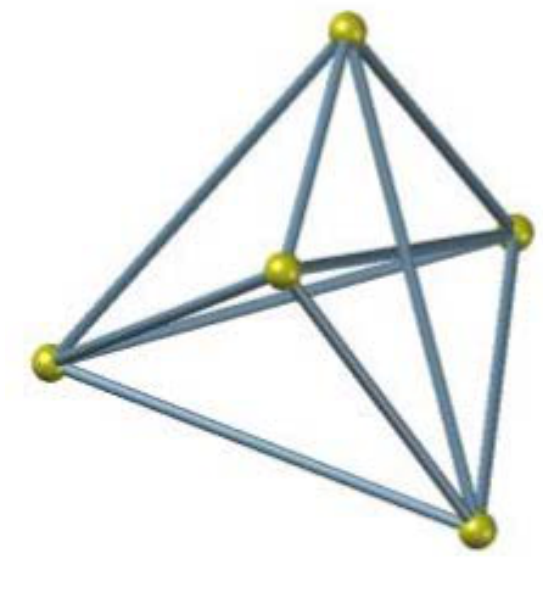
Figure 35: The pentachoron.